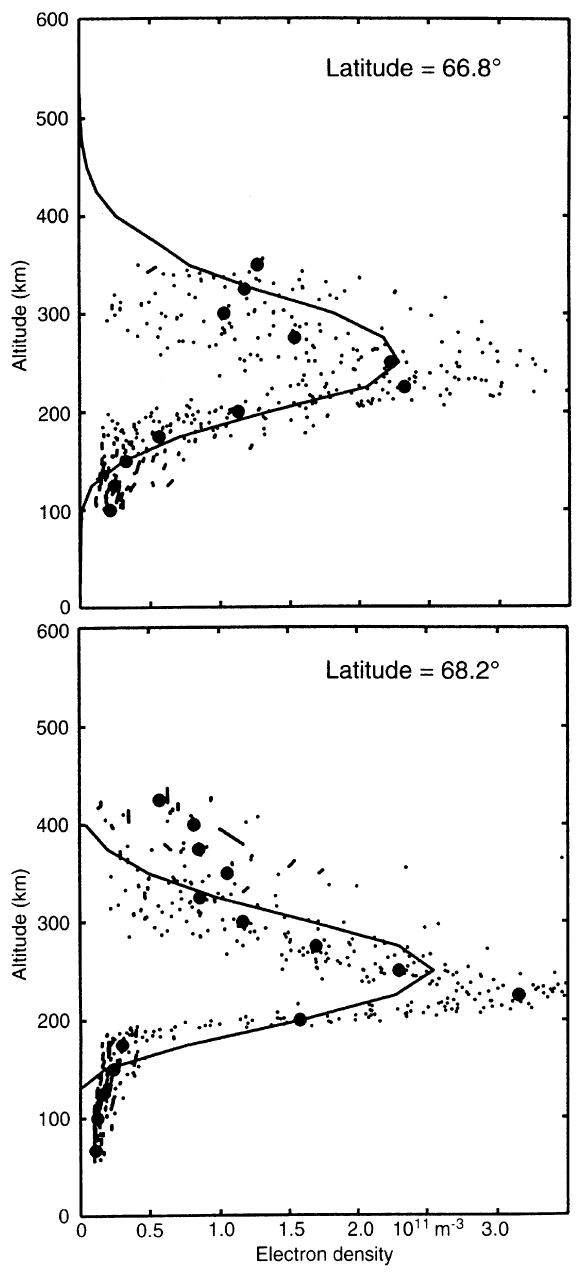
Fig. 2. Vertical electron density profiles at latitudes 66.8 ° and 68.2 ° from the measurements in Fig. 1. The continuous line indicates the tomographic observations, the large dots the averaged radar measurements from the second panel and the small dots the original radar measurements used in calculating the